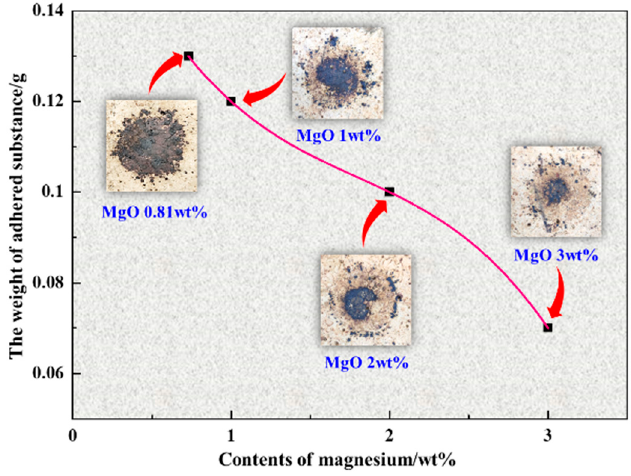
Figure 8. Effect of MgO on adhesion quantity of deposits to refractory brick.